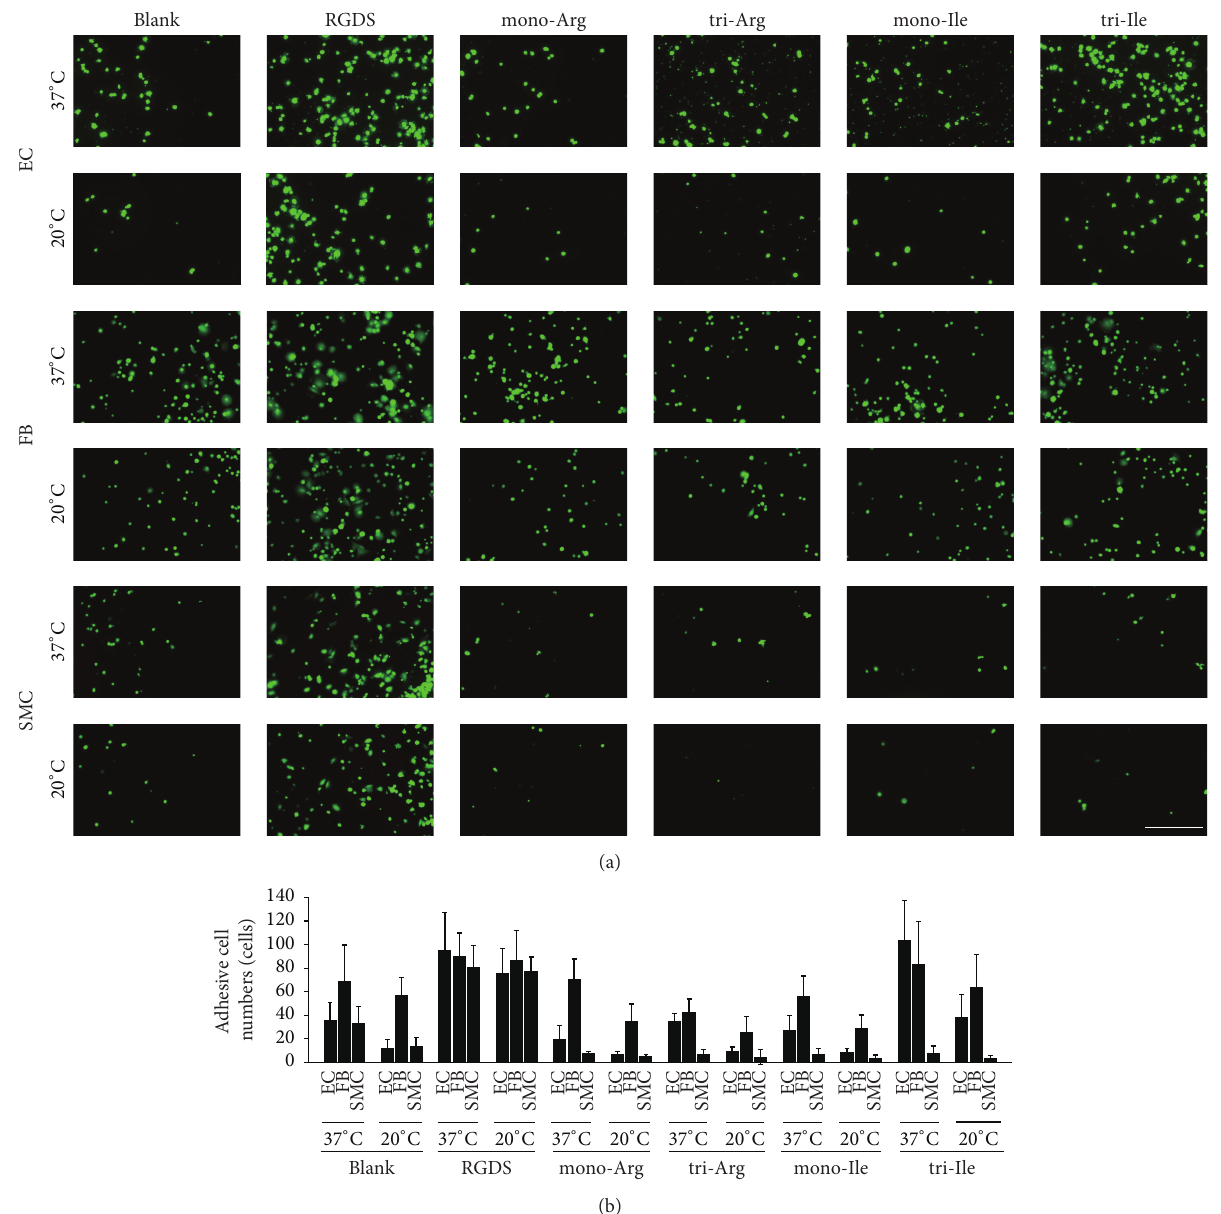
Figure 4: Cell adhesion performances on the biomolecule-immobilized cell assay platform. (a) Representative fluorescent image of viable cells in the cell adhesion assay (scale bar, 30 𝜇 m). (b) Quantitative results of images in (a) ( 𝑁 = 6 ). Blank (without biomolecules) and RGDS (positive